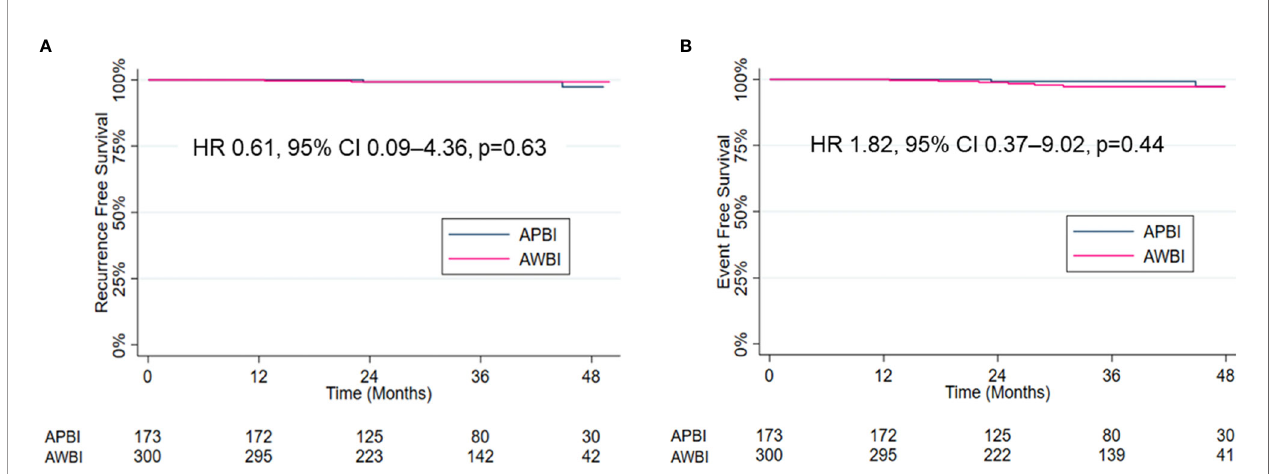
FIGURE 1 | Kaplan – Meier estimates and curves for recurrence-free survival (A) and event-free survival (B) .